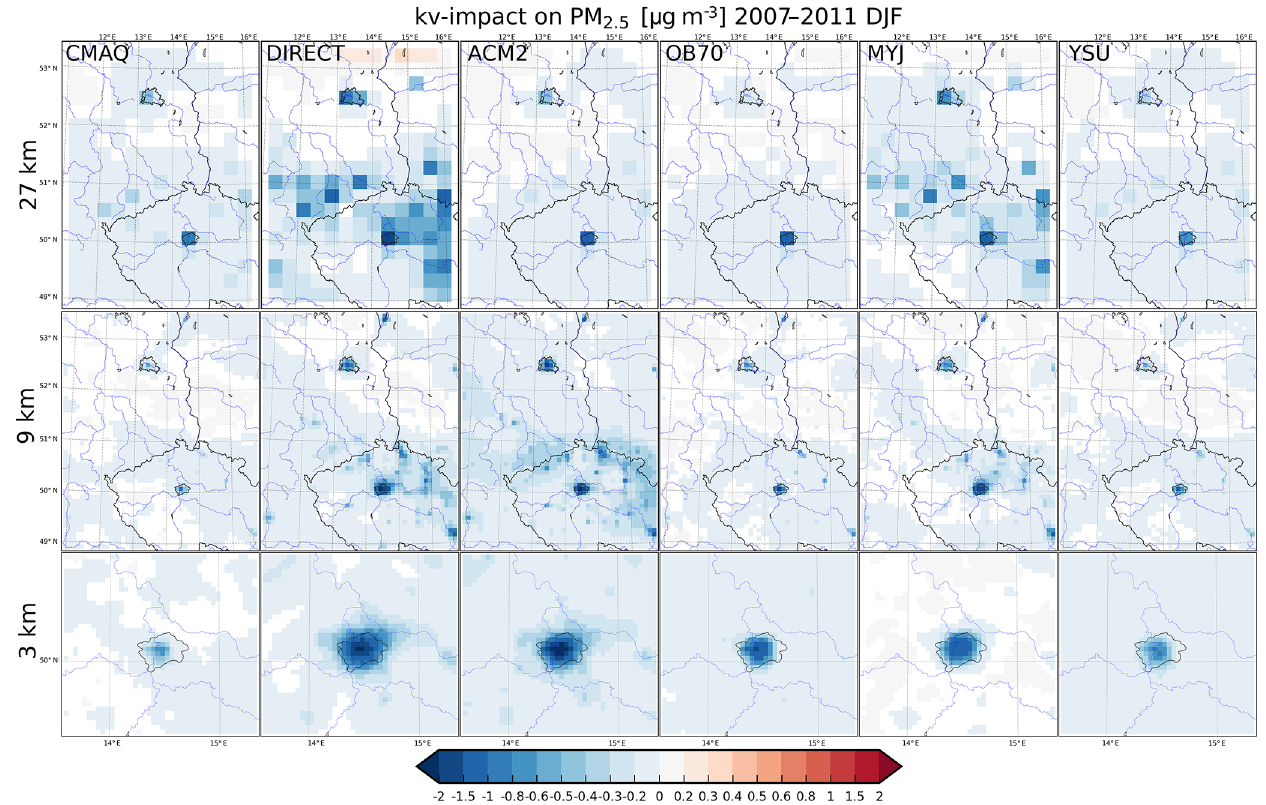
Figure 24. Same as Fig. 23 but for